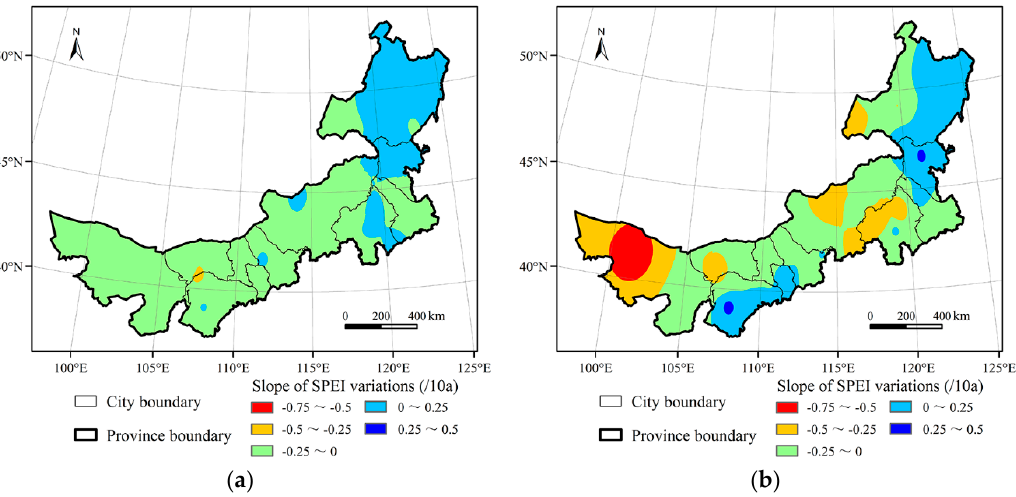
Figure 11. The annual SPEI spatial changes in (a) 1958–1992 and (b) 1993–2019.